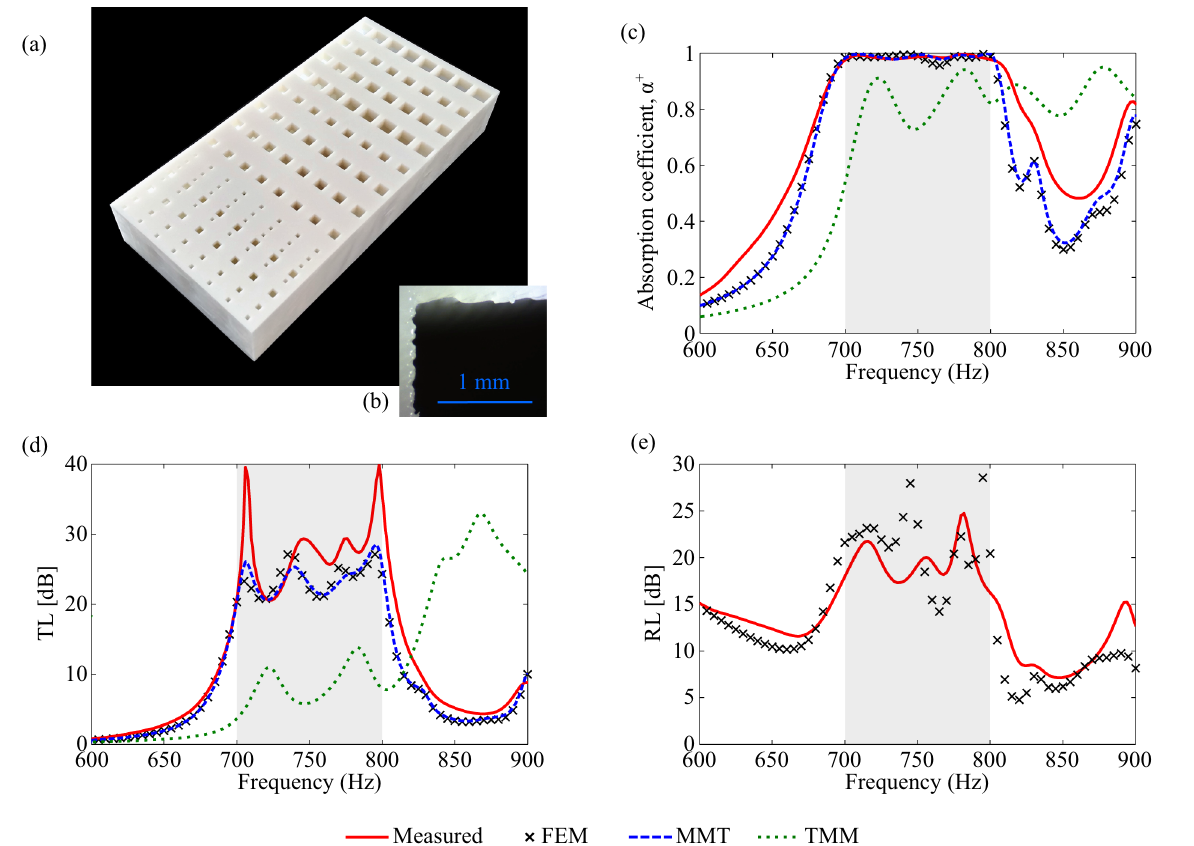
15 cm high duct. ( a ) Picture of the =